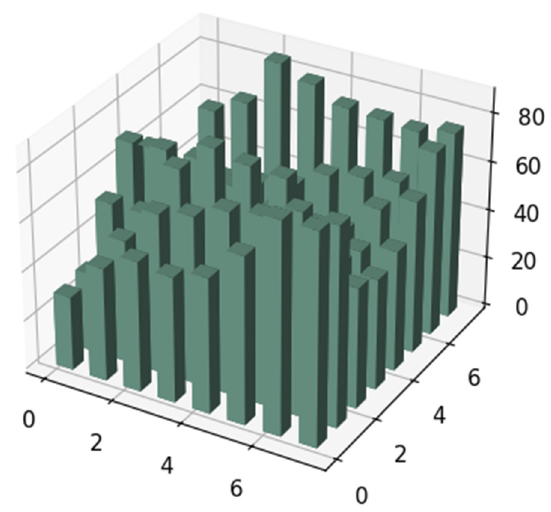
Figure 4. The luminance histogram for a block of 8 by 8 pixels. Since the range of values is 0–255, by subtracting 128 from each value, a range centered around 0 is obtained, shown in Figure 5.